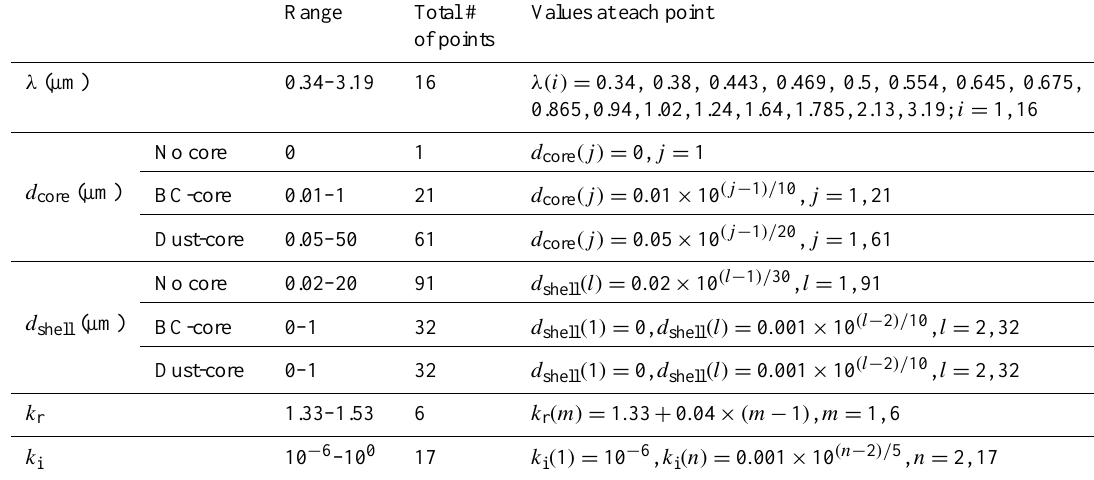
Table 1. The range of each dependent variable dimension, the total number of points in each dimension, and the values at each point for shortwave aerosol optical property look-up tables for particles without solid cores, particles with BC cores, and particles with dust cores.